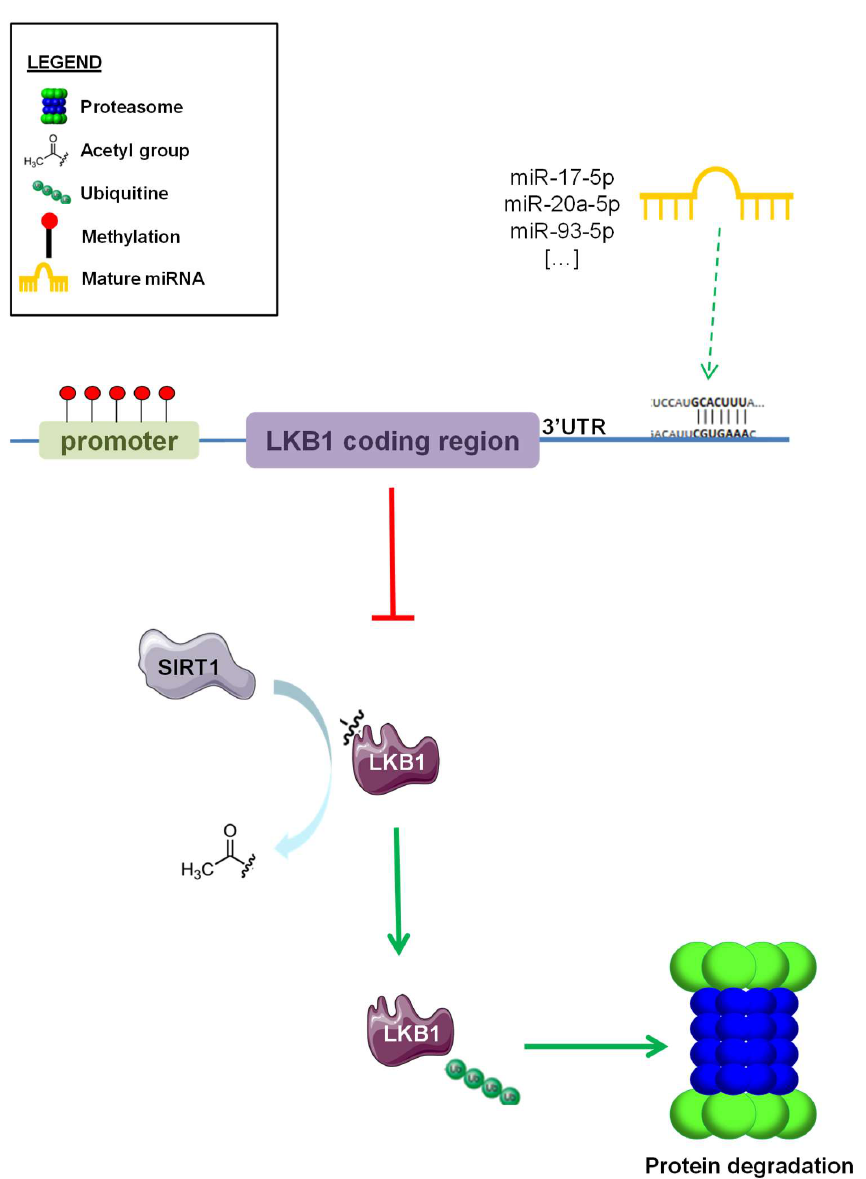
Figure 1. Epigenetic regulation of LKB1 expression. Different systems of epigenetic regulation of LKB1 protein expression. Promoter hypermethylation, miRNA-mediated modulation of LKB1 translation (i.e., miR-17-5p, miR-20a-5p, and miR-93-5p), and SIRT1-induced deacetylation and subsequent ubiquitination and proteasome degradation of LKB1. Green arrows indicate ubiquitination and proteasome degradation, red “T” arrow indicate inhibition of protein expression. LKB1 has been reported to have tumor suppressor activity also in AMPK-independent ways.